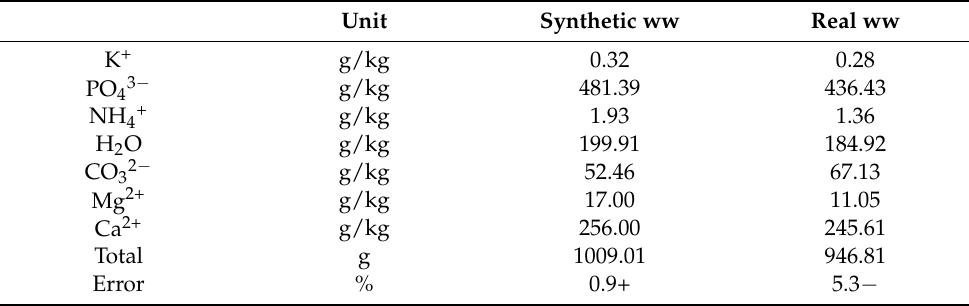
Table 6. Final precipitates comparison for real and synthetic wastewater operation.